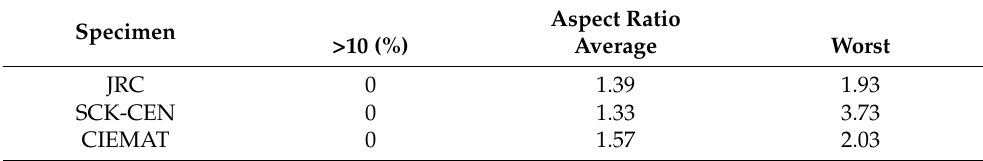
Table 4. Finite element mesh statistics.